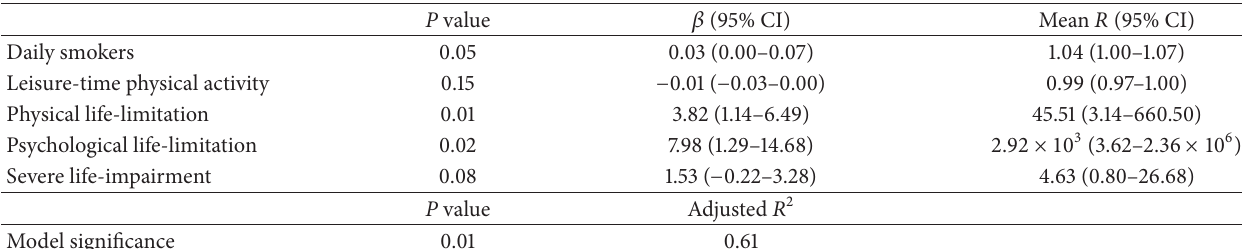
Table 4: Final multivariate linear regression model involving factors presenting statistical significance and/or clinical relevance. P